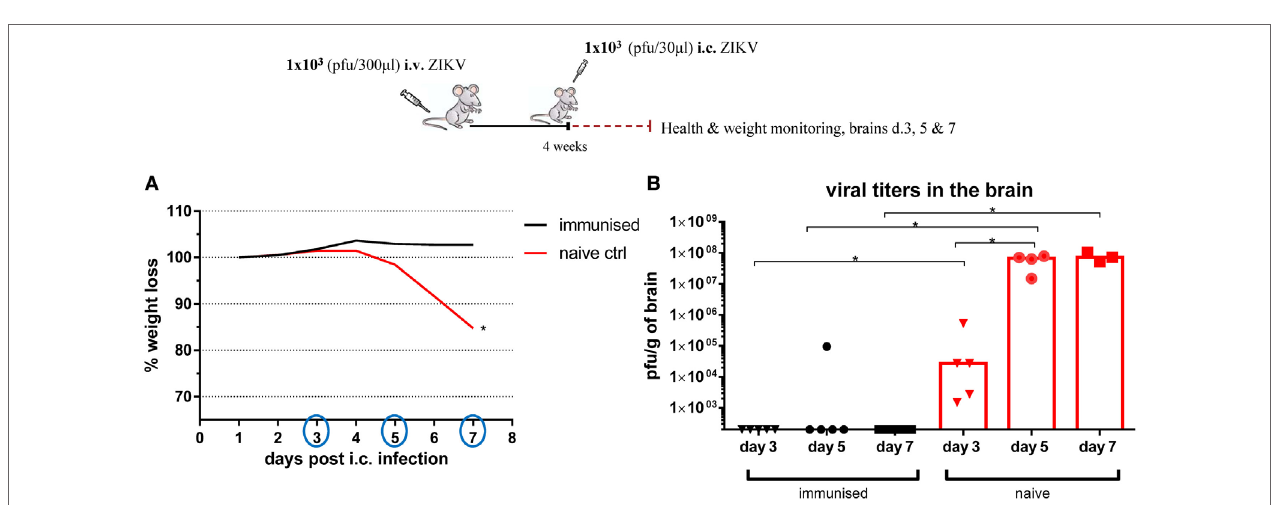
FigUre 3 | Kinetics of virus control after i.c. challenge. Wild-type C57BL/6 mice were inoculated with 1 × 10 3 pfu Zika virus (ZIKV) i.v., and 4 weeks later, these mice and naïve controls were challenged with 1 × 10 3 pfu ZIKV i.c. Mice were weighed and monitored daily (a) , and on days 3, 5, and 7 post i.c. challenge, brains were removed and viral titers were measured by a plaque assay (B) . The detection limit for virus in the brain was 250 pfu/g organ. Each dot represents an individual animal and bars the medians of the groups. The weight curves depict the group medians. n = 3–5 mice/group, * p <